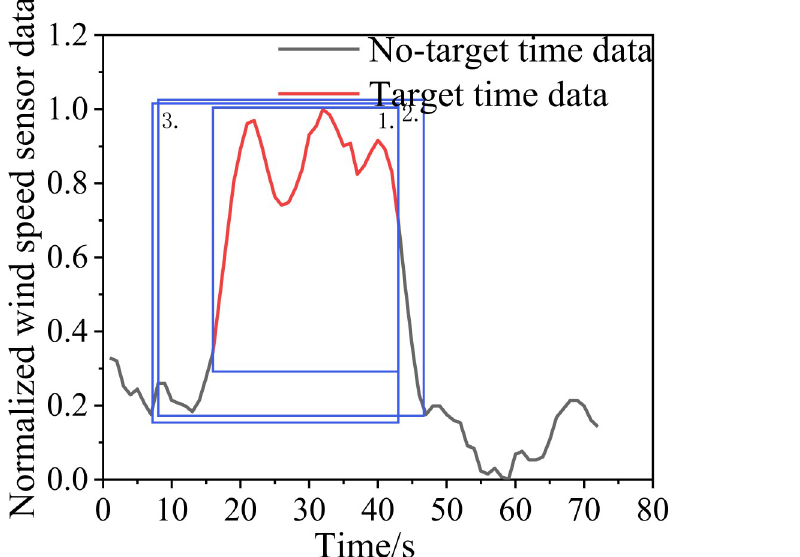
Fig 20. Initial identification results with